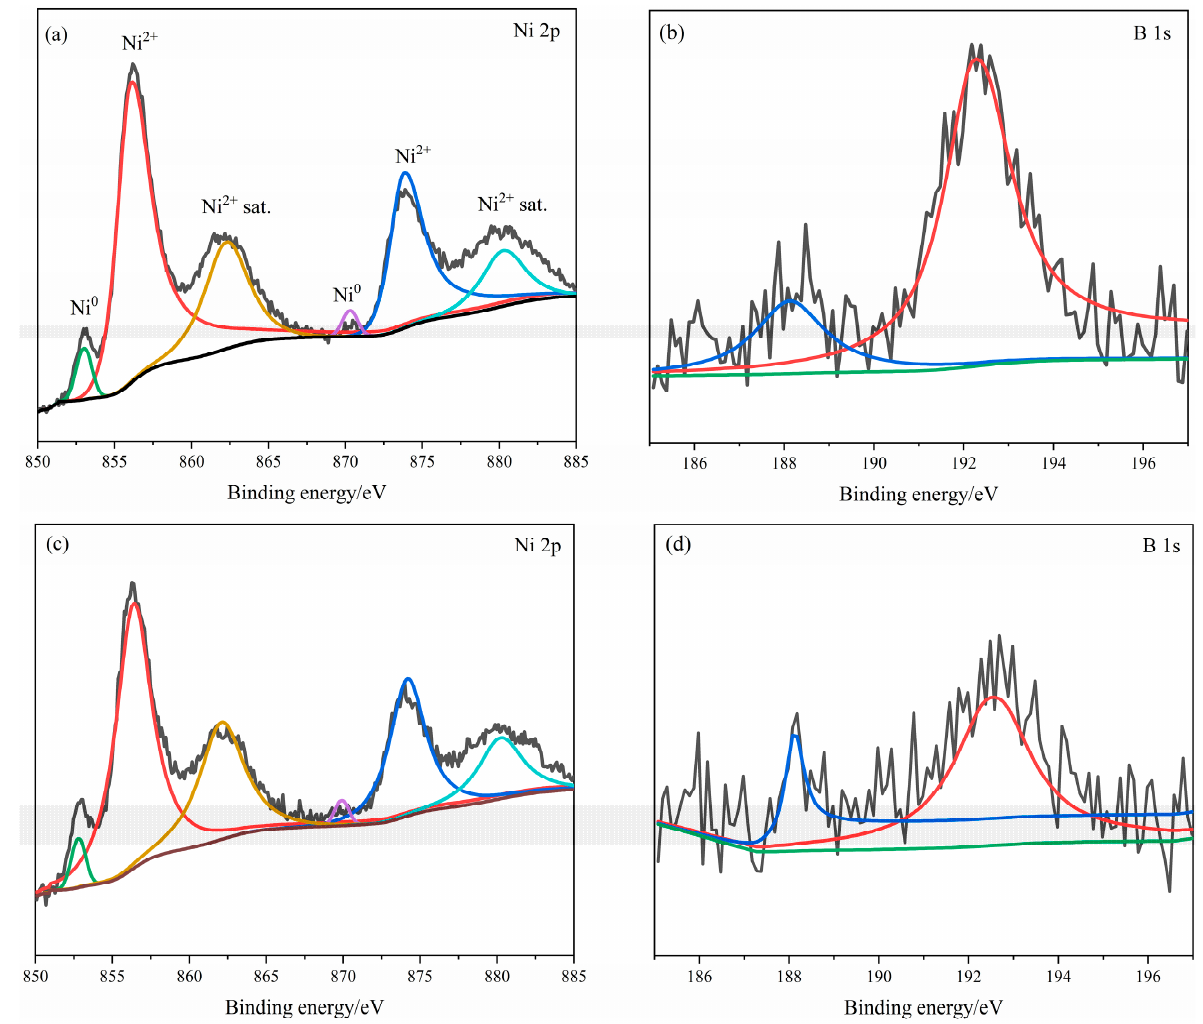
Figure 2. ( a ) Ni 2p, ( b ) B 1s XPS spectra of fresh catalyst. ( c ) Ni 2p, ( d ) B 1s XPS spectra of used catalyst.